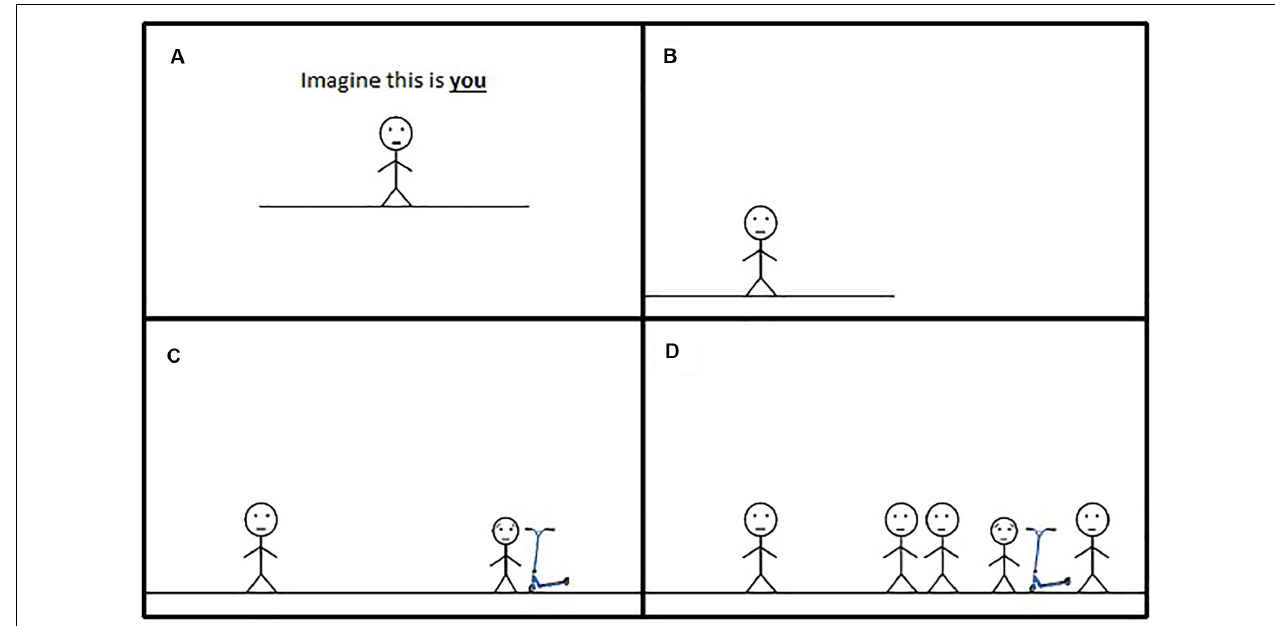
FIGURE 1 | One of the twelve scenarios used in the RHP vignette measure (panel letters added for display purposes in this report only). Slides were presented to each child in the alphabetical order shown. This specific scenario showed a physically smaller [than participant’s stick figure representation], not very tough opponent, who was accompanied by friends/allies.